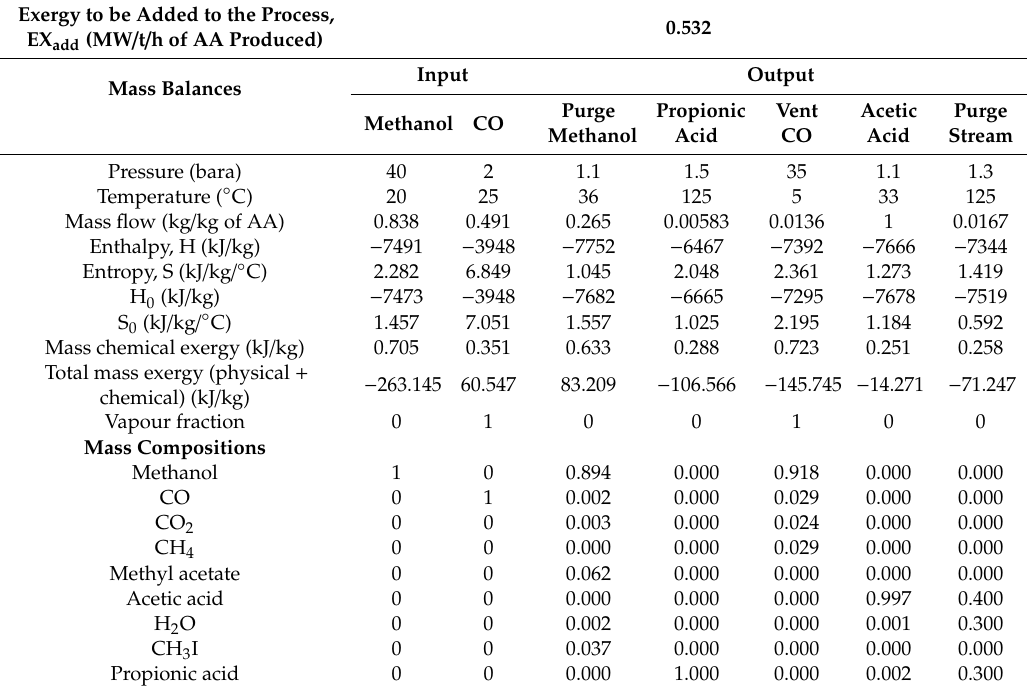
Table 1. Data of acetic acid production, derived from